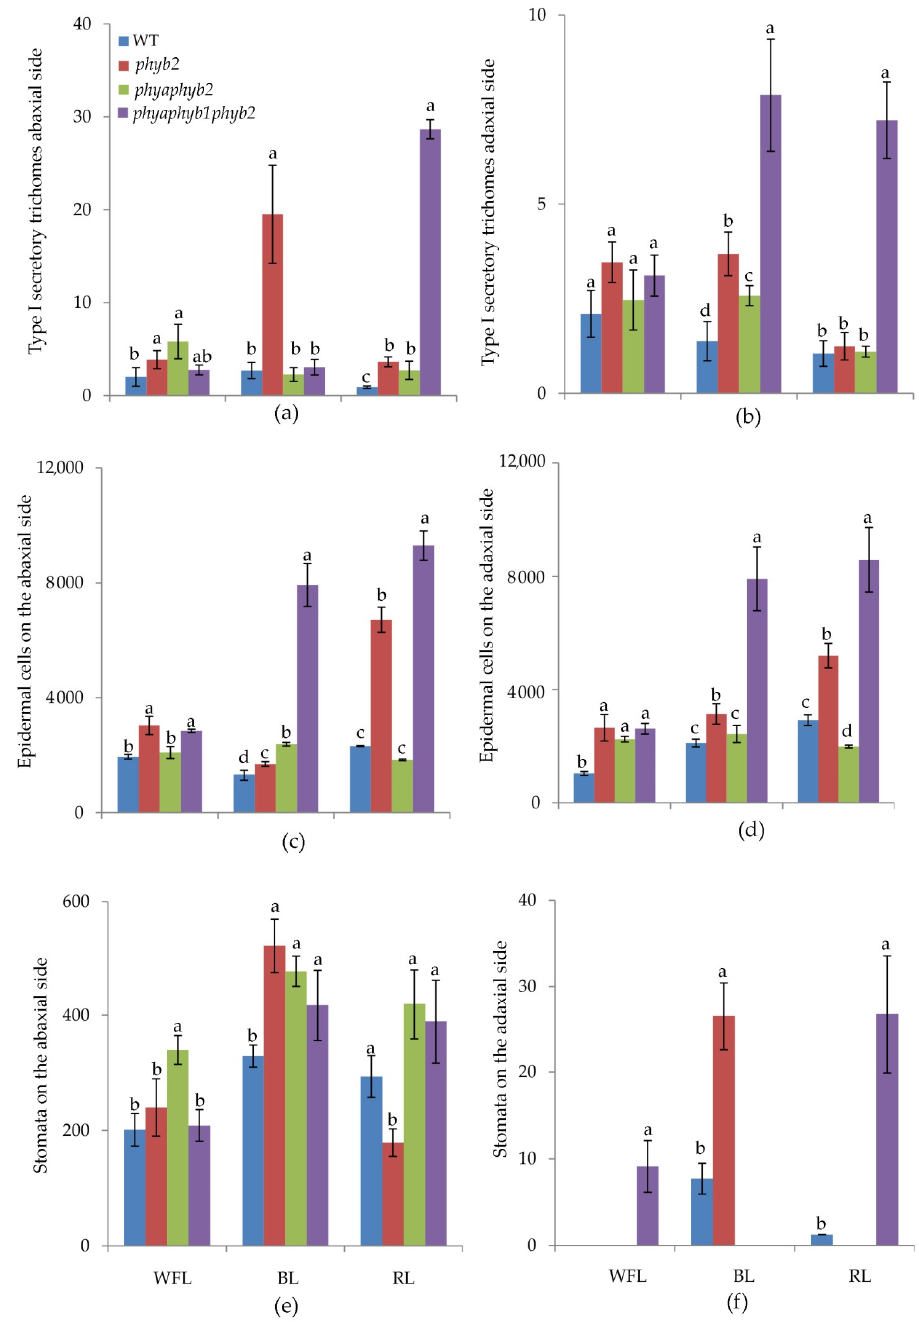
Figure 2. Effect of WFL, BL, and RL on the number of type I secretory trichomes ( a , b ); number of epidermal cells ( c , d ) and number of stomata ( e , f ) per mm 2 on abaxial ( a , c , e ) and adaxial ( b , d , f ) sides of leaves. Different letters indicate significant differences ( p < 0.05) between the experimental treatments. The means ± standard errors, n =